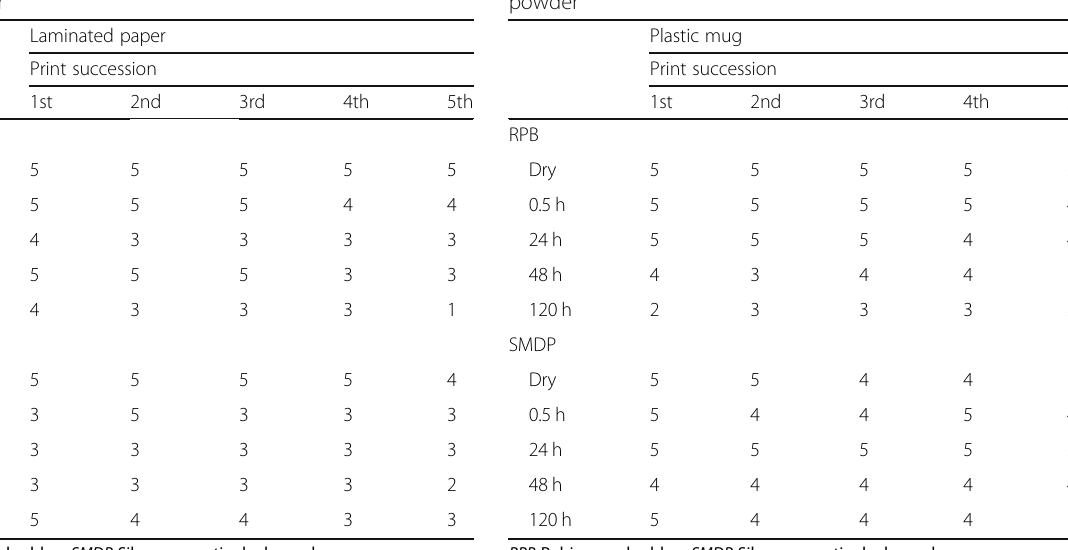
Table 4 Development of submerged and successive prints